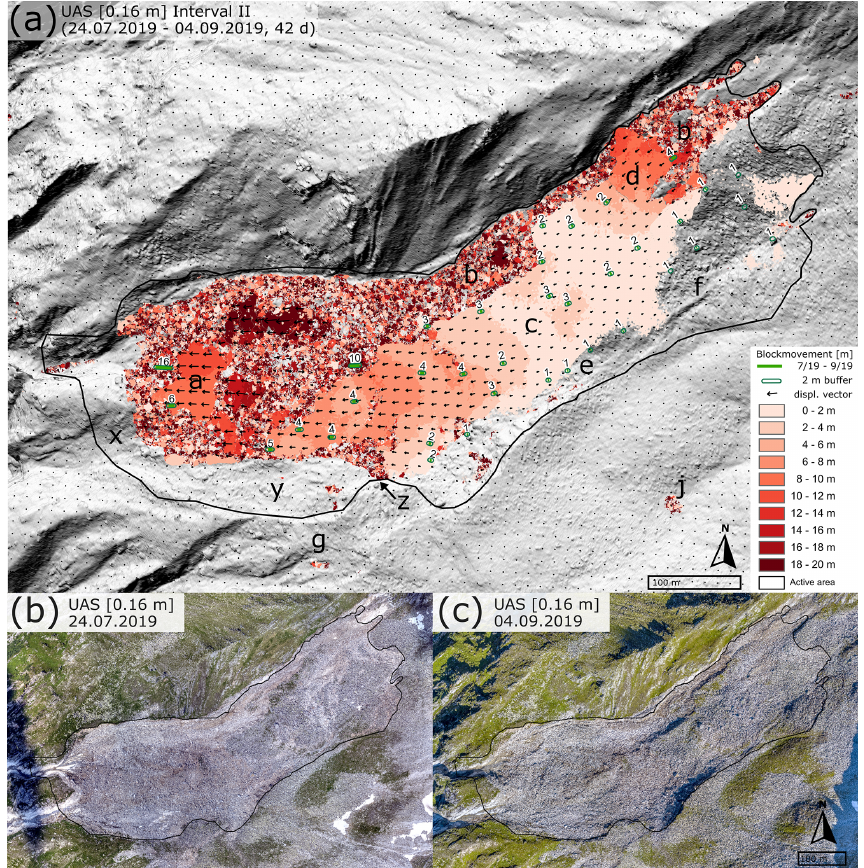
Figure 6. (a) Displacement derived from UAS data at a 0.16m resolution for interval II (24 July–4 September 2019, 42d) combined with boulder trajectories (in metres) manually measured in the UAS orthophotos in the same time period. Displacement vectors show landslide flow (black). Origin of inconsistently tracked features (a) for b and the northwestern landslide head are described in Sect. 5.2. The solid black line represents the boundary of the active landslide based on field mapping. Background: UAS hillshade, 24 July 2019 (0.08m), orientation − 3 ◦ from north. UAS orthophotos at a 0.16m resolution for the master (b) and slave image (c) of the corresponding time